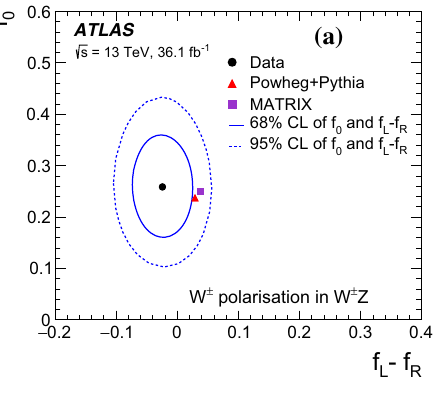
prediction and the effect of QCD scale uncertainties on the MATRIX prediction are of the same size as the triangle marker. The full and dashed ellipses around the data points correspond to one and two stan- dard deviations, respectively